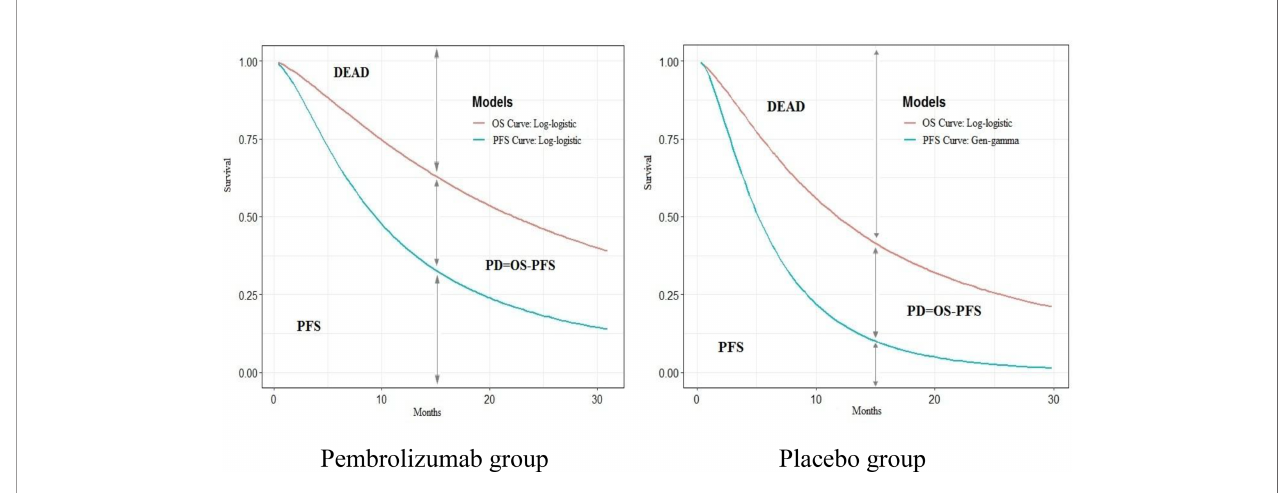
FIGURE 1 | Construction of partitioned survival model in the pembrolizumab and placebo group.